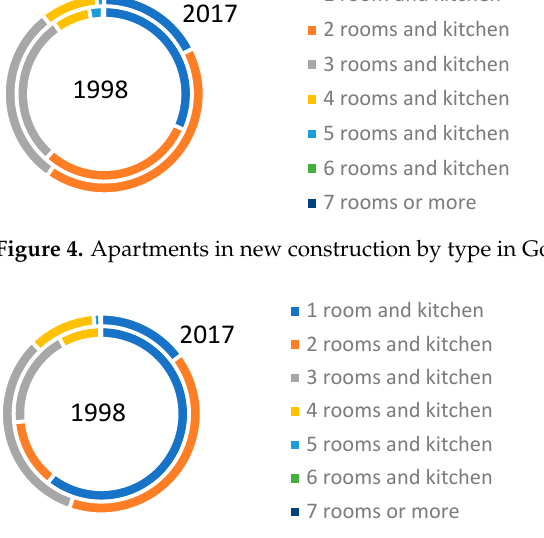
Figure 5. Apartments in new construction by type in Malmo region in 1998 and 2017.